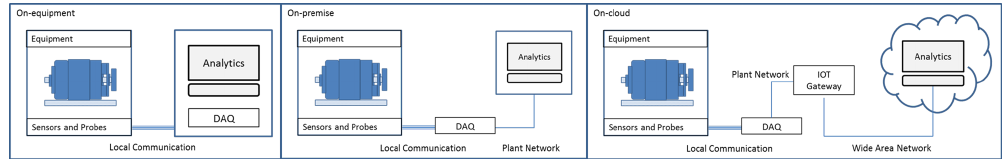
Figure 4. Monitoring system integration in industrial